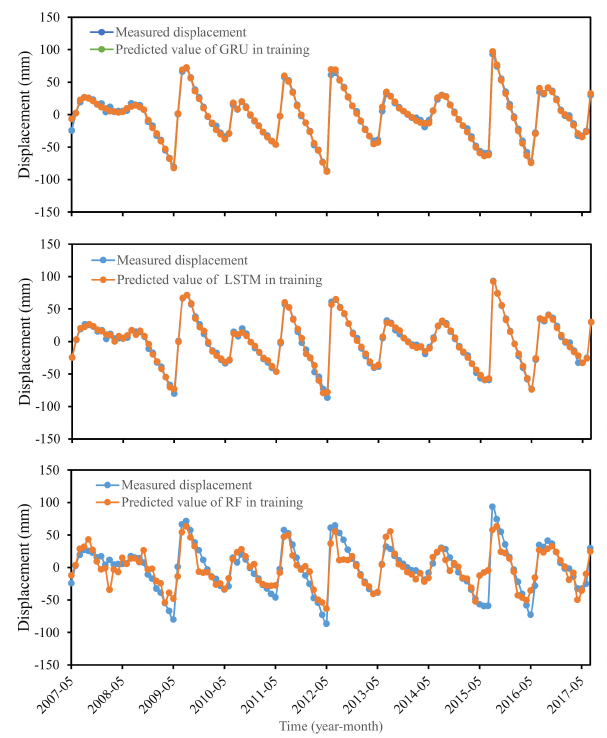
Figure 13. Measured and predicted displacements of GRU, LSTM, and RF models in